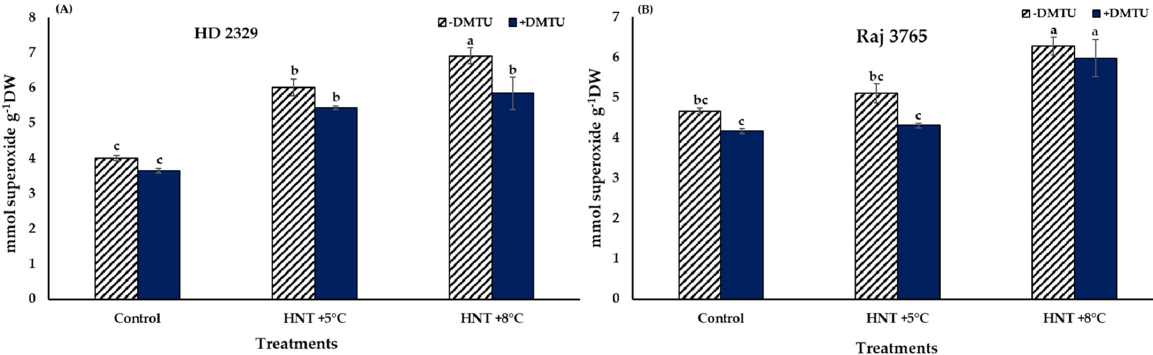
Figure 4. Effect of HNT on hydrogen peroxide content in pistil of wheat genotypes ( A ) HD 2329 (sensitive) and ( B ) Raj 3765 (tolerant) under control, HNT (+5 °C) and HNT (+8 °C) conditions in absence and presence of ROS scavenger (DMTU). Bars represent mean ± SE. Bars with common letter are not significantly different between temperature treatments in a genotype at p < 0.05. Diaminobenzidine (DAB) staining of pistil also gave a clear indication and con- formed to the quantitative measurements (Figure 5). The susceptible genotype showed